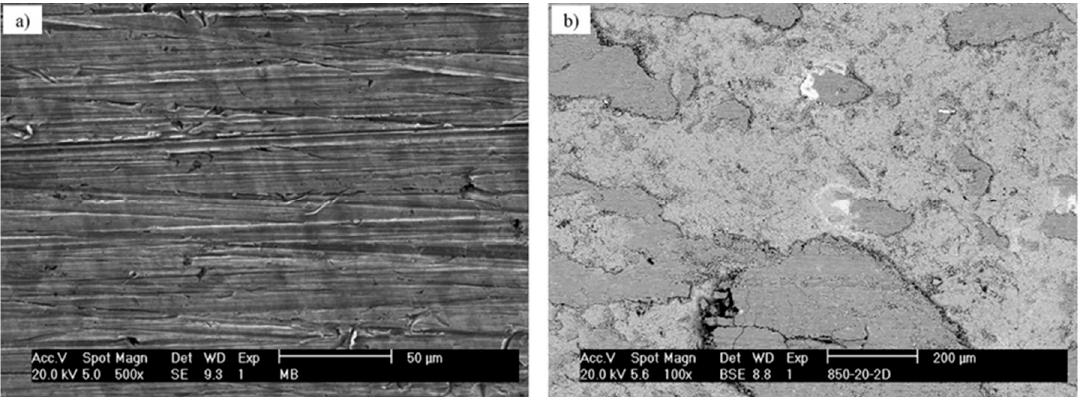
Figure 13. SEM images of specimens of AISI 304L stainless steel after pin-on-disk wear testing, ( a ) untreated, and ( b ) coated with α -Al 9 FeMnSi (processed at 900 °C and 20 MPa).